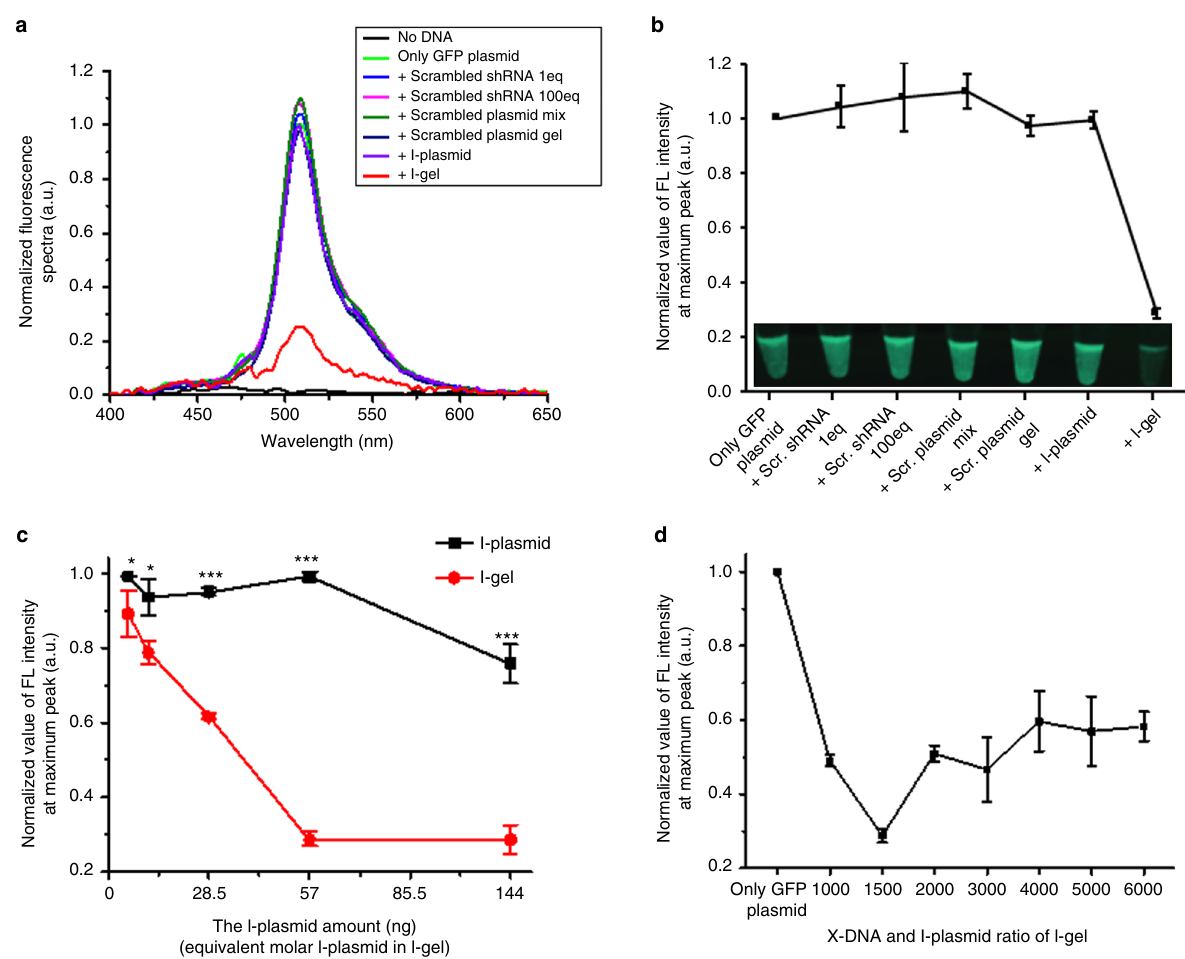
Fig. 2 Optimization and evaluation of I-gel. a The FL spectra of GFP in each condition (no plasmid, only GFP expression, addition of scrambled shRNA 1 eq, scrambled shRNA 100 eq, scrambled plasmid mixture, scrambled plasmid gel, I-plasmid, and I-gel). b A comparison of the fl uorescence intensities at the peak points of the graph ( a ) and the inset is fl uorescence images of each sample. The relative FL intensity ( c ) with the addition of increasing amount of I- plasmid and I-gel (* P < 0.05, ** P < 0.005 and *** P < 0.001, analyzed by t test. Asterisks indicate statistically signi fi cant differences between I-plasmid and I-gel), ( d ) with the variation of X-DNA and I-plasmid ratio in I-gel. For all experiments, 57 ng of I-plasmid has been used except ( c ). This data was obtained by in vitro transcription/translation with HeLa cell lysate system. Error bars refer to standard deviations from three